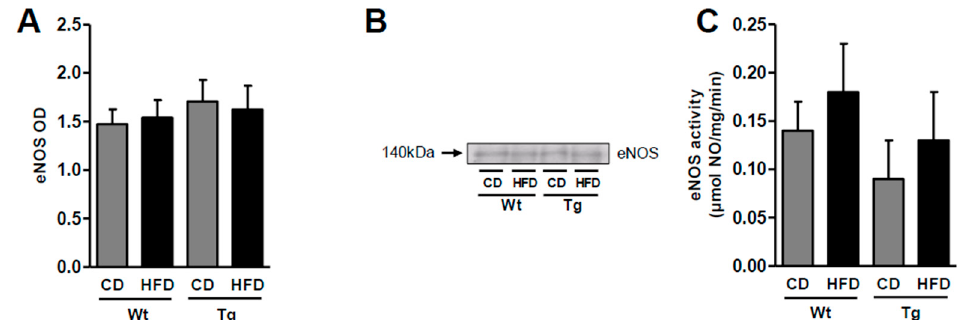
Figure 2. Protein expression, as detected by Western blot analysis, of the total endothelial nitric oxide synthase (eNOS) ( A ) with representative blots ( B ) and nitric oxide synthase (NOS) activity ( C ) in aortas from control (Wt) and transgenic (Tg) mice fed the control diet (CD) or a high-fat diet (HFD). The data represent seven mice per group. OD: optical density.